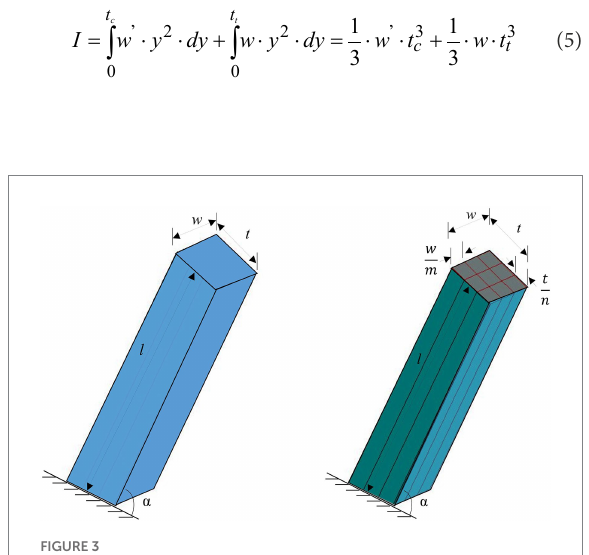
FIGURE 3 Relative loading conditions of rock beams before and after slabbing. Left: before slabbing; Right: after